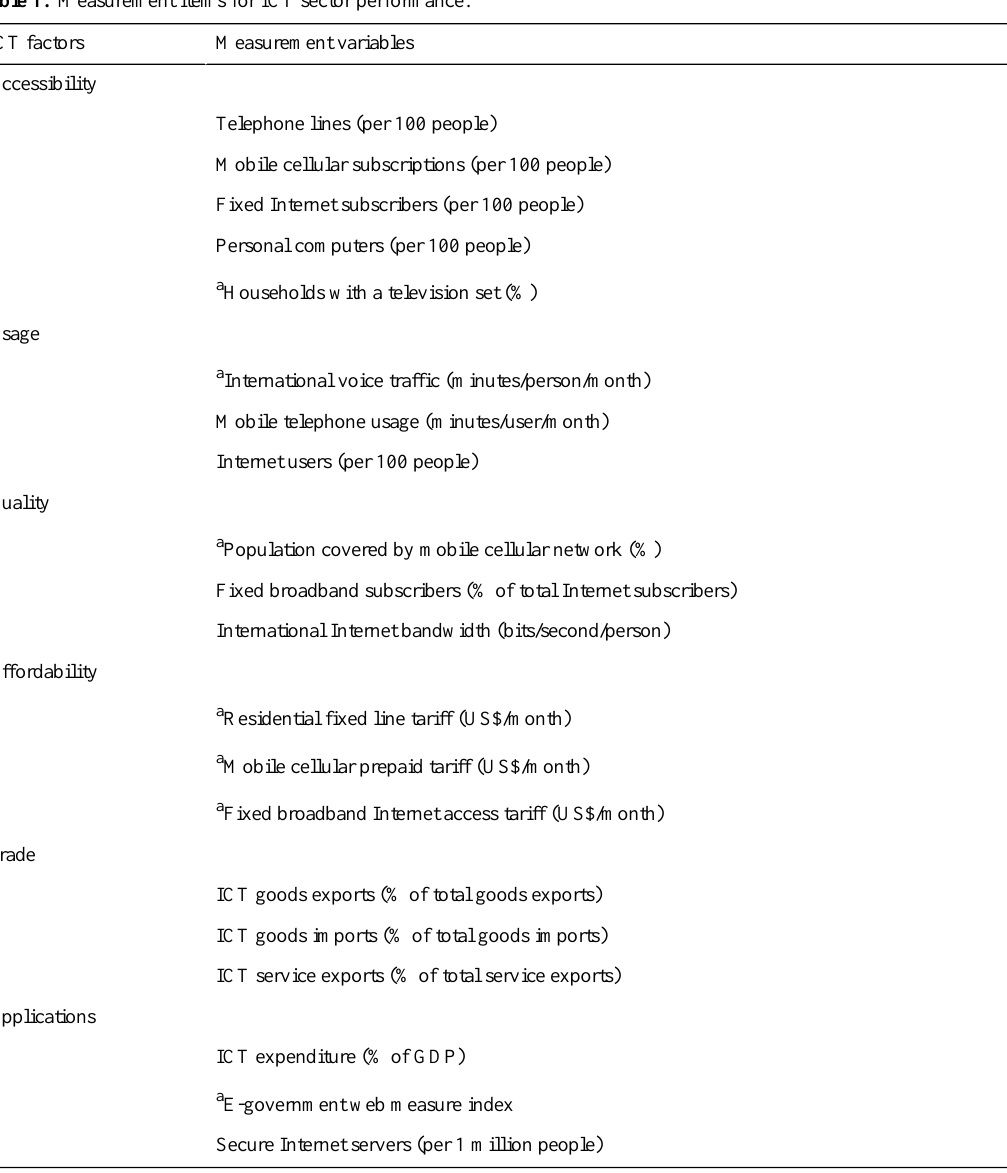
Table 1. Measurement items for ICT sector